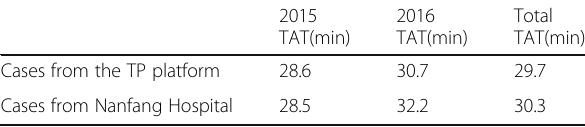
Table 1 TAT comparison between cases from the TP